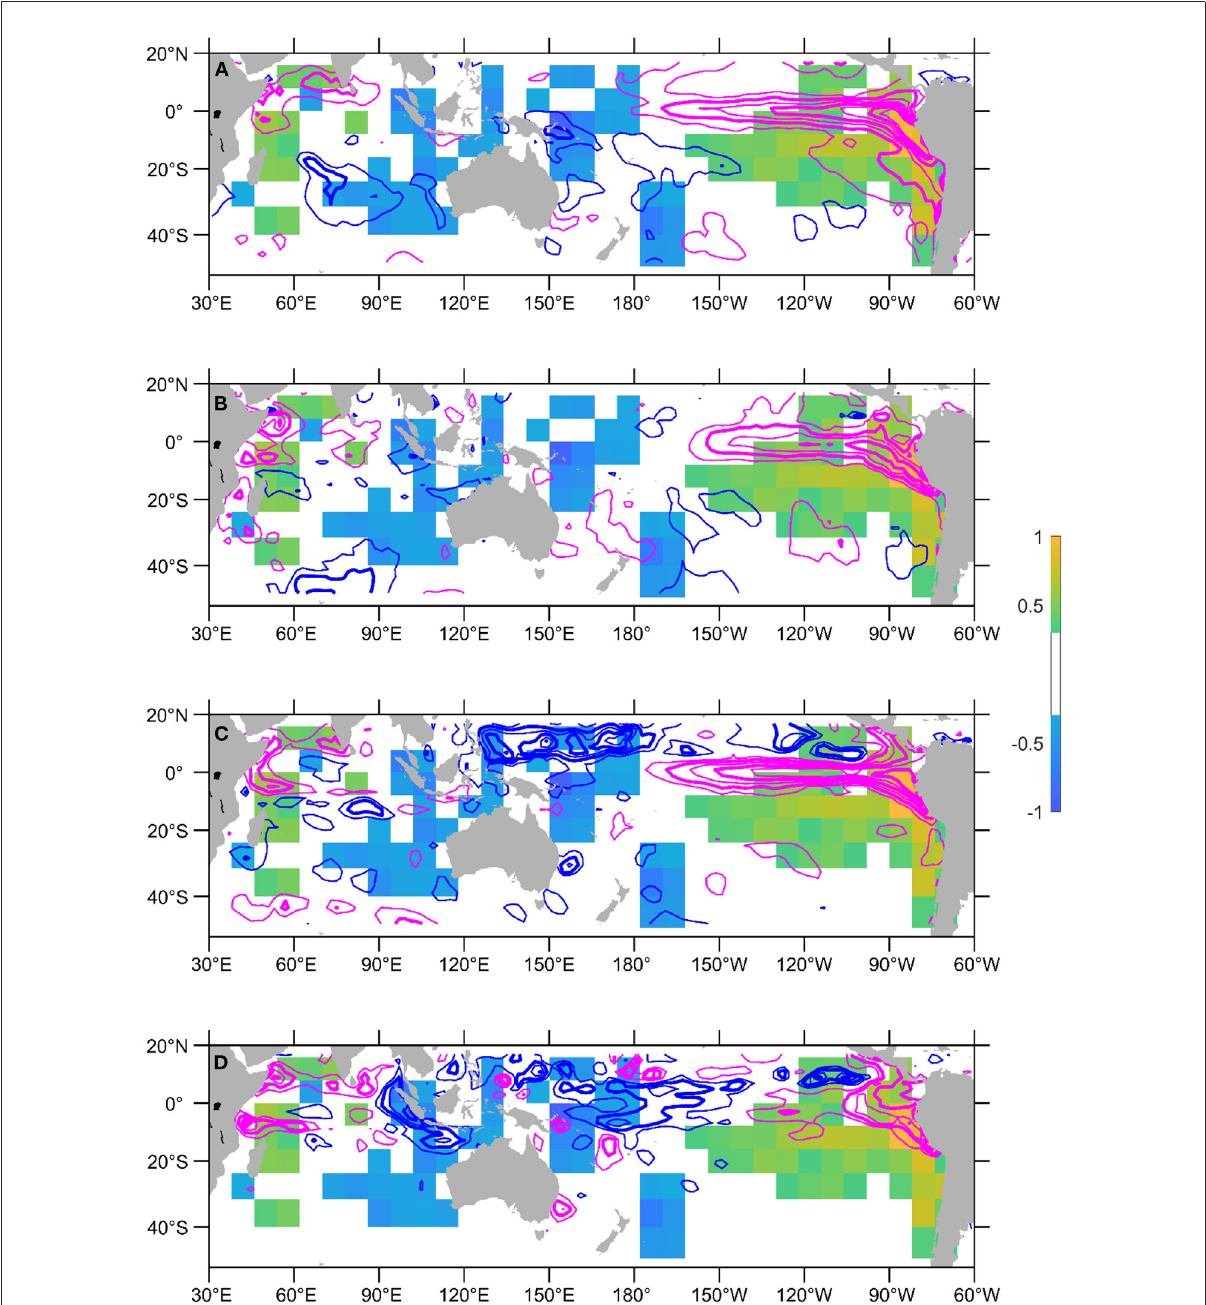
FIGURE6 Activation map of using June-July-August SST and heat content anomalies to forecast the October 1997 EIOD peak (only showing absolute values > 0.3). The activation map is overlaid with (A) SST anomalies in July 1997, (B) SST anomaly differences between August and June 1997, (C) heat content anomalies in July 1997, and (D) heat content anomaly differences between June and August 1997. Negative anomalies are denoted with blue contours and positive anomalies with magenta. Anomalies are plotted every 0.5 ◦ C, and the integer values are in bold contour. Zero contour lines are not